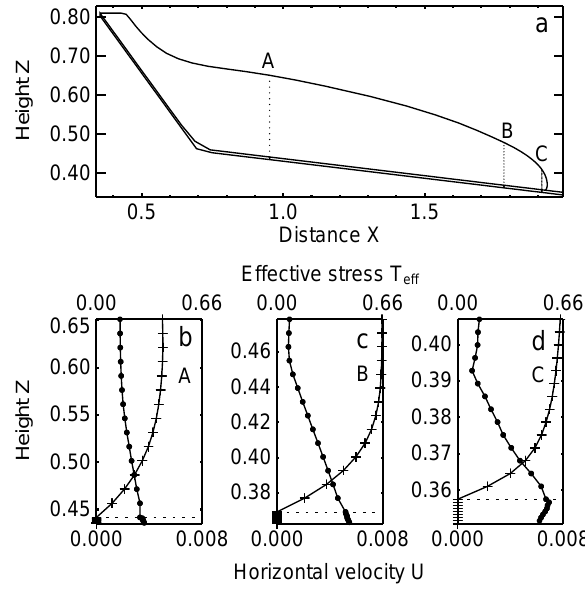
Fig. 3. Experiment A: Relatively stiff and moderately non-linear till ( m = 3, B = 8): (b–d) vertical profiles of the non-dimensional horizontal velocity U (lines with crosses) and effective stress T eff (lines with dots) are shown at a dimensionless time T = 15.4 for the three locations A, B and C shown in (a) . Note that the vertical scale changes for each profile.